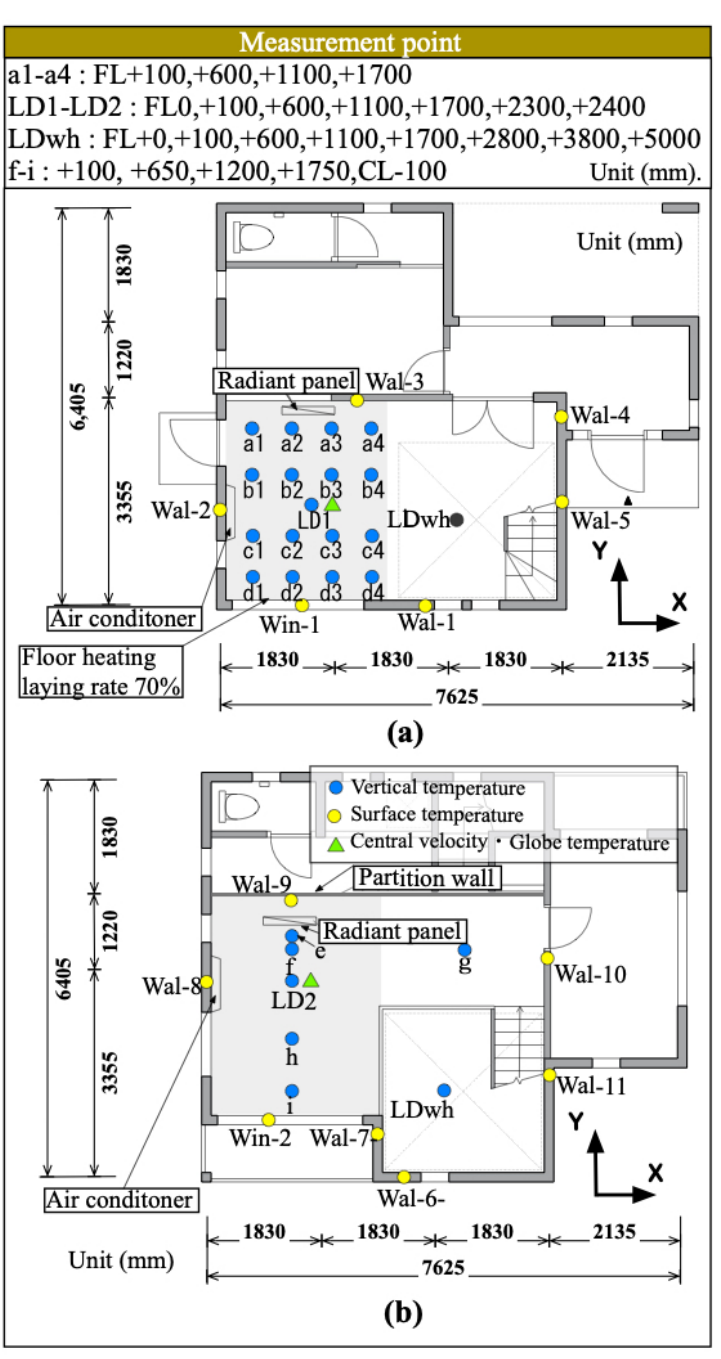
Figure 3. Floor plans and experimental measurement points for the first and second floors: ( a ) first-floor plan and measurement points; ( b ) second-floor plan and measurement points. FL, floor; CL, ceiling [3]. Table 2. Experimental conditions.